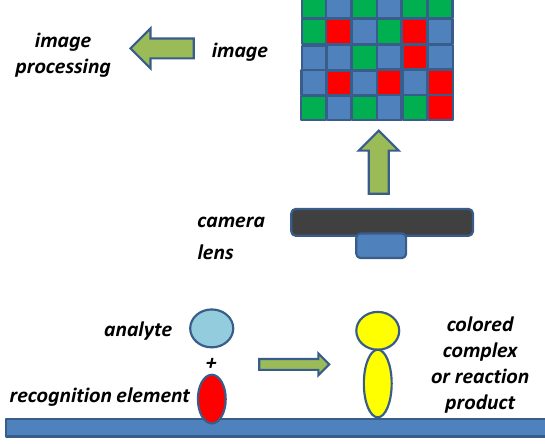
Figure 2 General principle of a bioassay with digital camera as the